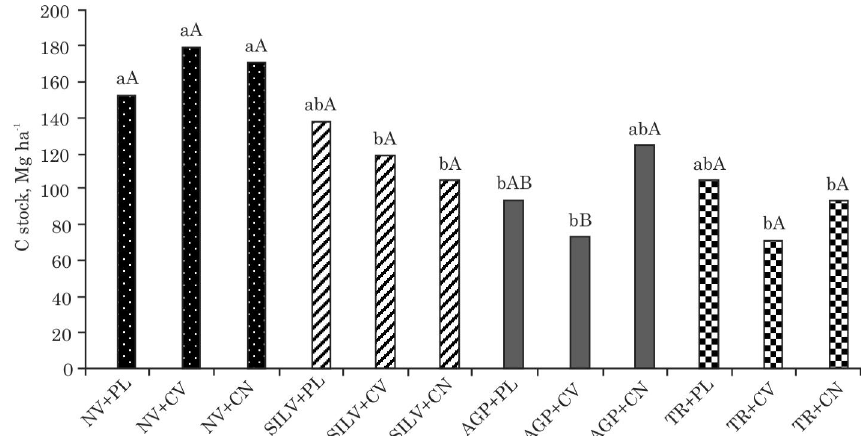
Figure 4. Soil TOC stocks in the 0-60-cm layer in a typical Ortic Chromic Luvisol under natural vegetation (NV) and silvopastoral (SILV), agrosilvopastoral (AGP) and traditional agricultural (TR) systems in plain (PL), convex (CV) and concave (CN) landforms after using Luvisol for 13 years in Sobral, Ceará. Means followed by similar letters do not differ by Tukey’s test at 5 %; uppercase letters compare the landforms in each area and lowercase letters compare the areas in each landform.